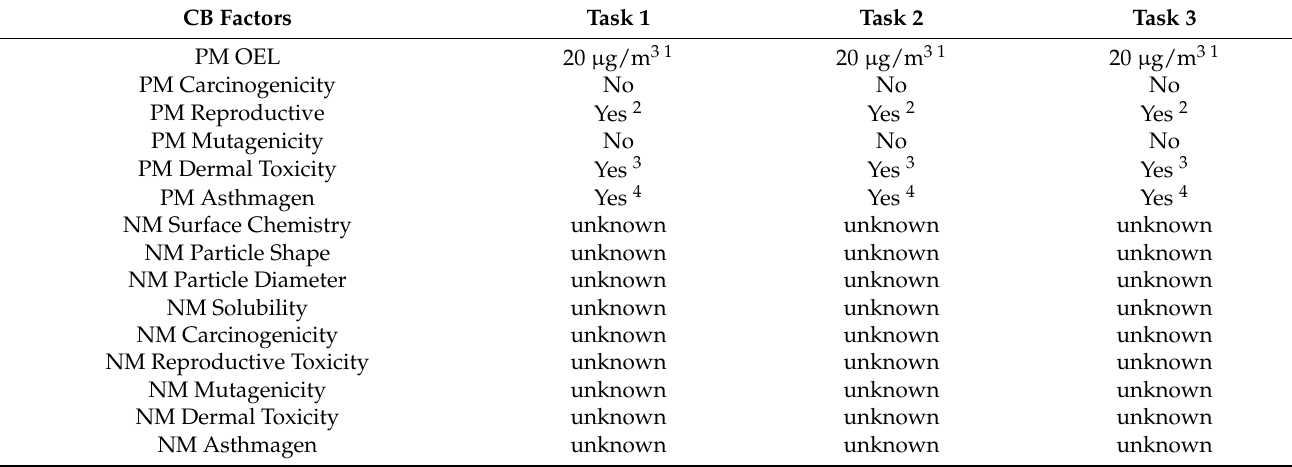
Table 4. Results of the application of CB Nanotool version 2.0 for the conditions of Trial